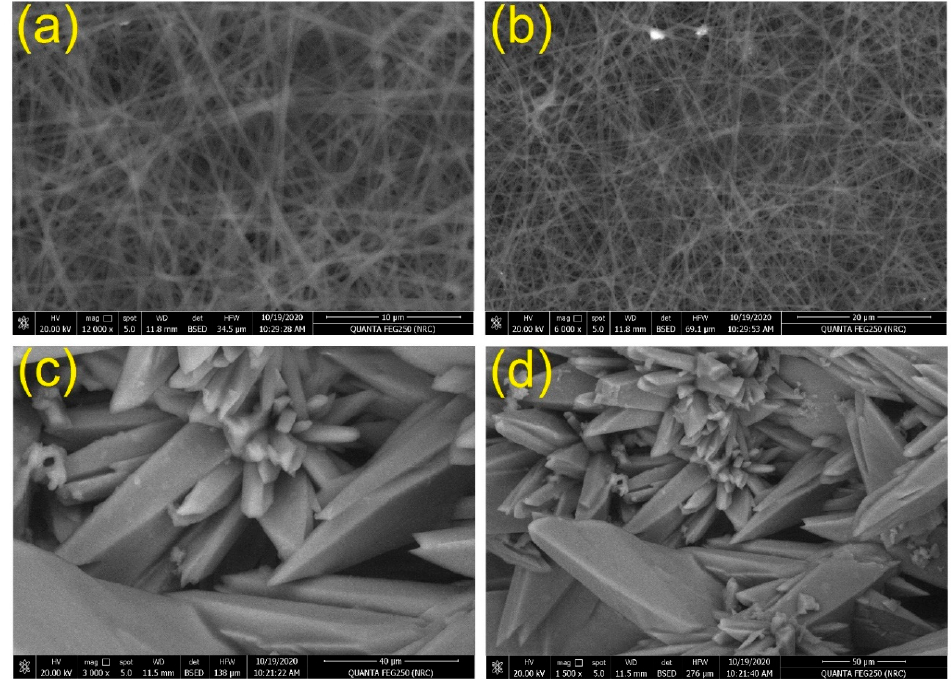
Figure 6. SEM images of the dried UTCFH xerogels obtained from DMSO with a total content of TCFH at 0.06 wt% ( a , b ), and 0.2 wt% ( c , d ).